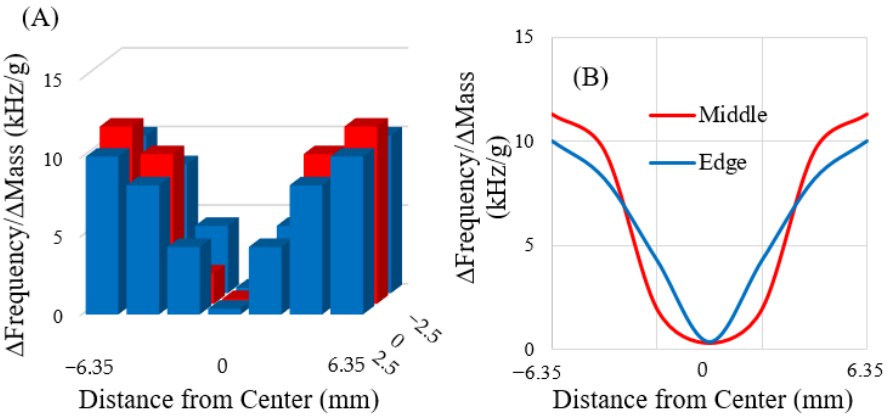
Figure 7. Charts illustrating the range of sensitivities that exist across the sensor surface in 3D ( A ) and as 2D lines along the length of the sensor ( B ). The rectangular sensors were assumed to behave symmetrically. The horizontal axes in both figures represent the entire length of the sensor, with the center of the sensor defined as the origin.